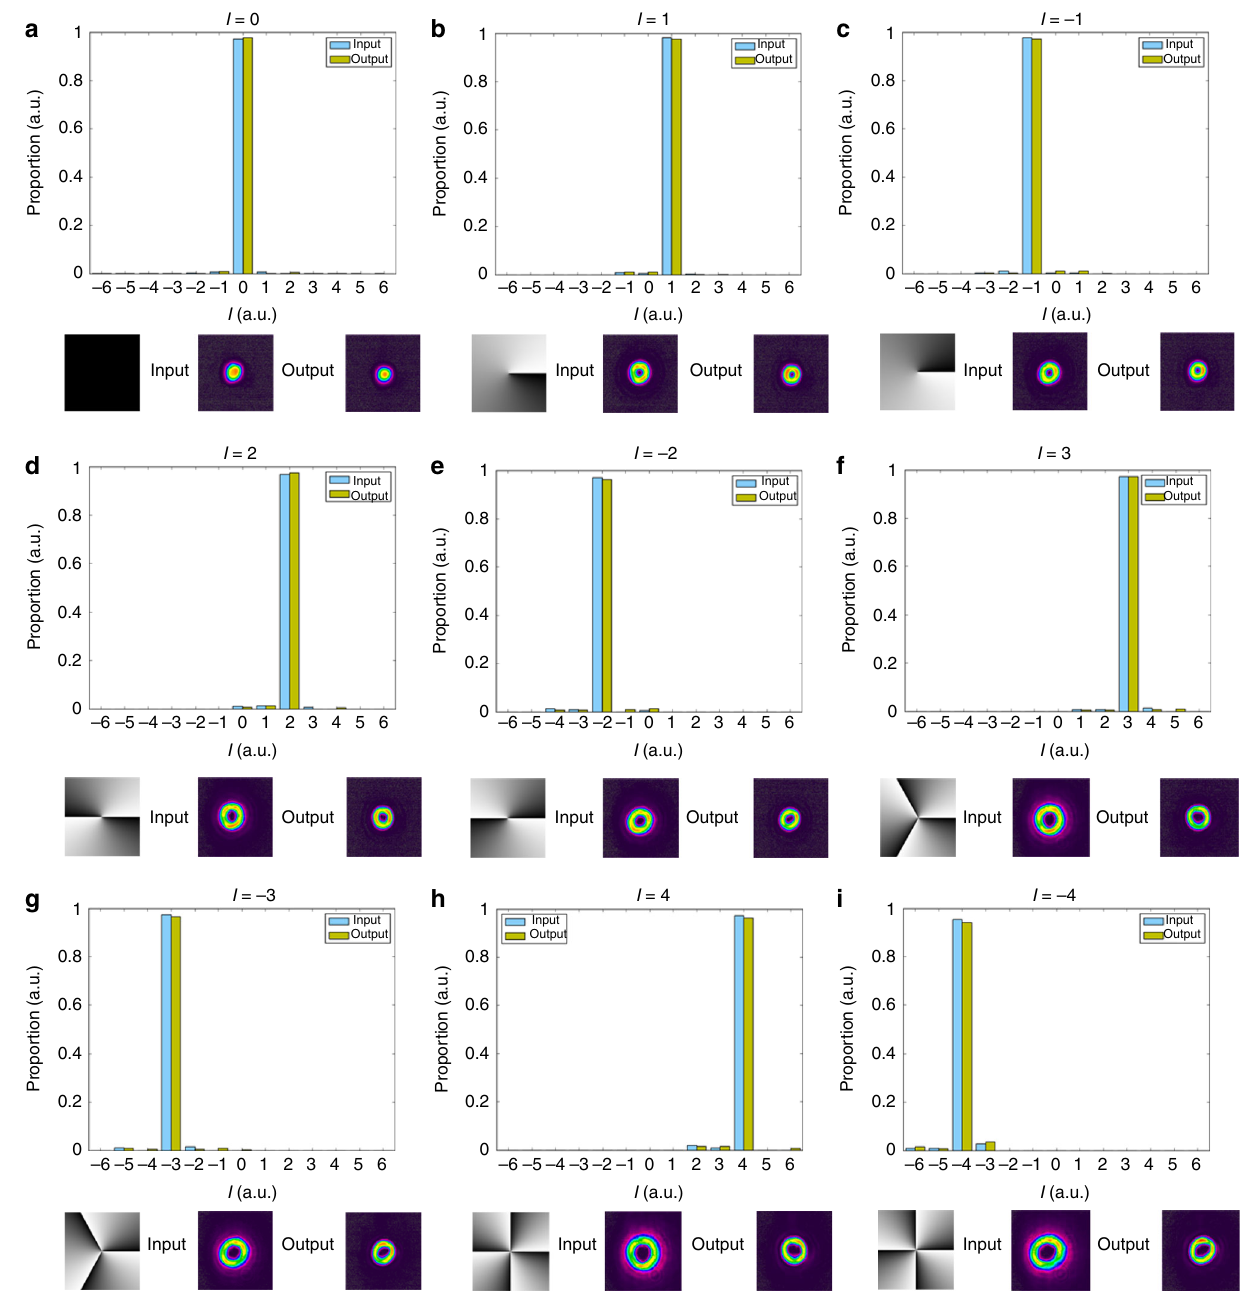
Fig. 5 Orbital angular momentum mode analysis for the input and output fi elds. The bottom row in each sub fi gure shows the computer-generated hologram for OAM mode and the corresponding images of input and output fi ¼ ^ a þ ^ a teleporting ^ a is same as the one for teleporting in in ;‘ in ; (cid:2) ‘ ^ a ¼ ^ a ( ^ a ) because the squeezing levels of EPR entangle- in in ;‘ in ; (cid:2) ‘ ment for these two cases are equal 39 . In our experiment, the slight difference between the fi delities for these two cases is caused by